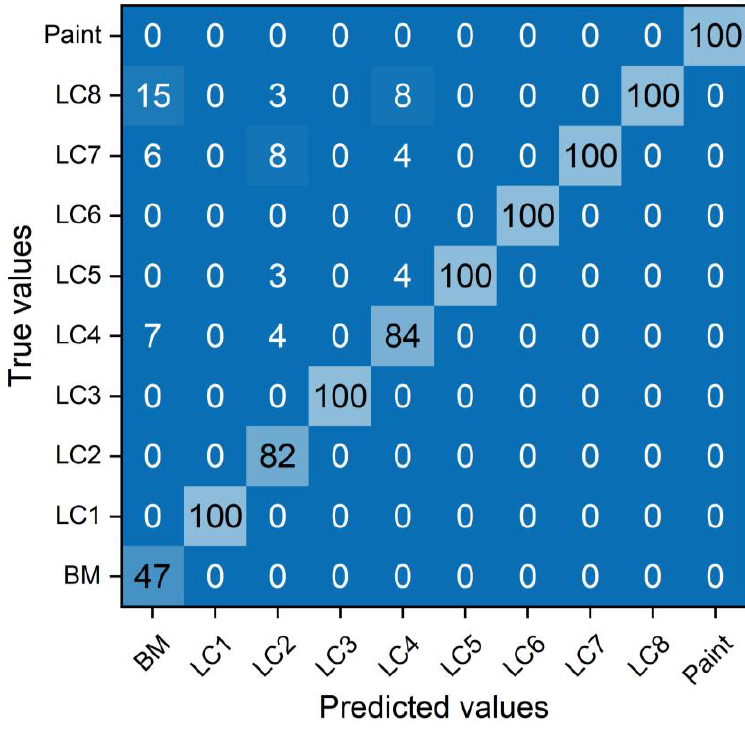
Figure 6. Confusion matrix after 15 epochs.